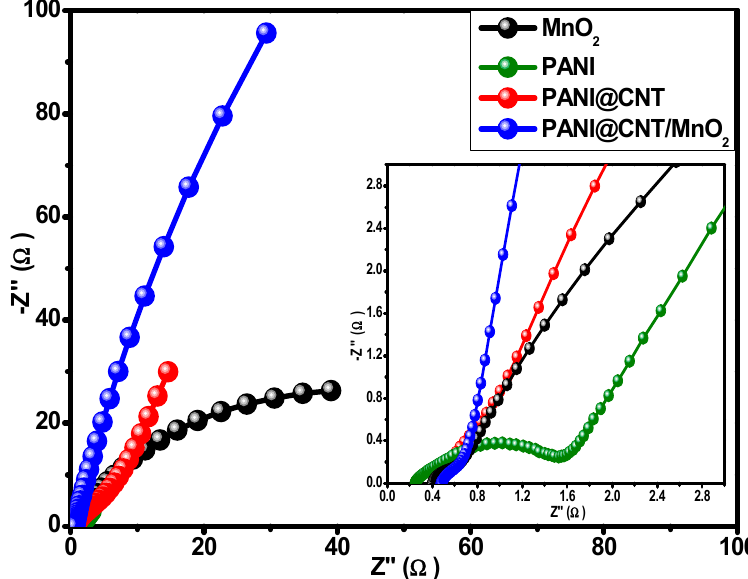
Figure 7. Nyquist plots of the MnO 2 nanorods, fibrous PANI, PANI@CNT, and PANI@CNT/MnO 2 ternary composite. Inset Figure 7 shows the electrochemical impedance spectroscopy (EIS) spectrum in high frequency region.